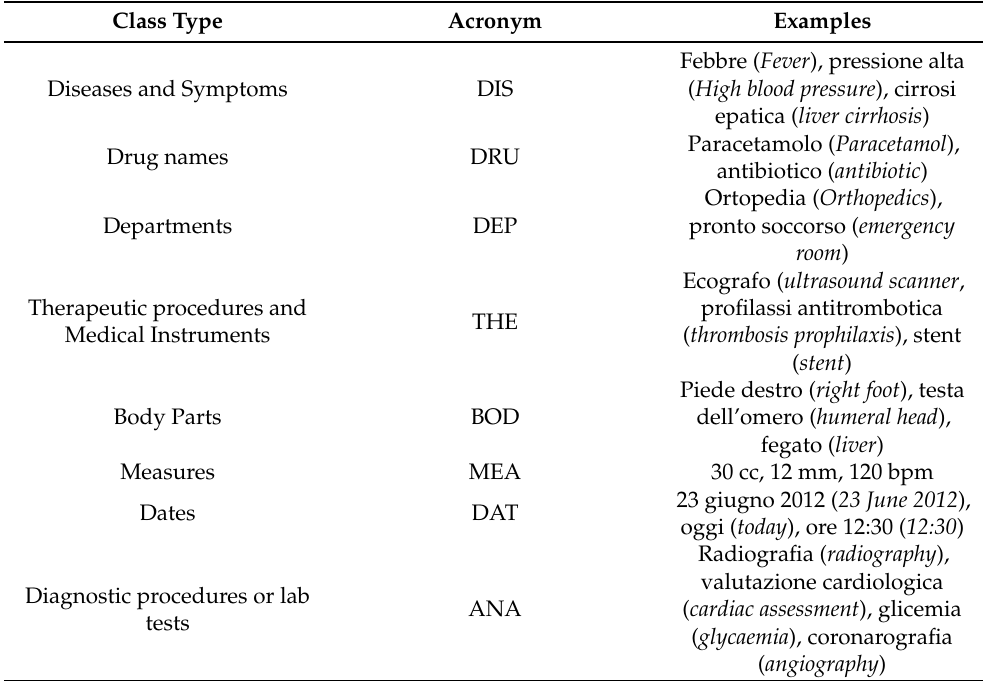
Table 1. Entity classes with corresponding acronyms and examples. The English translation of the examples is in italics between